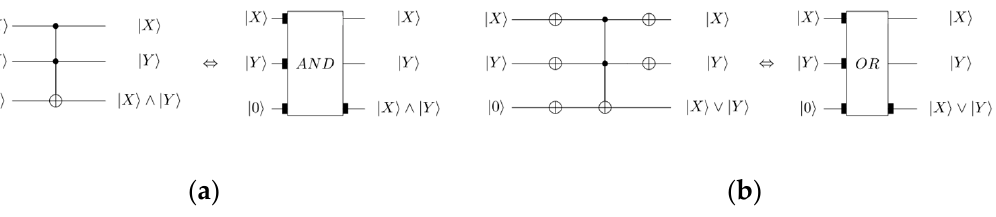
Figure 5. Logic operation circuit. ( a ) Logic operation ∧ (AND). ( b ) Logic operation ∨ (OR).